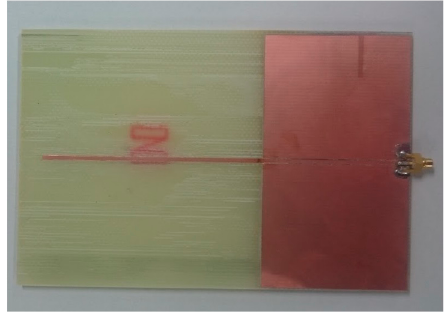
Figure 11. Photograph of the fabricated antenna.